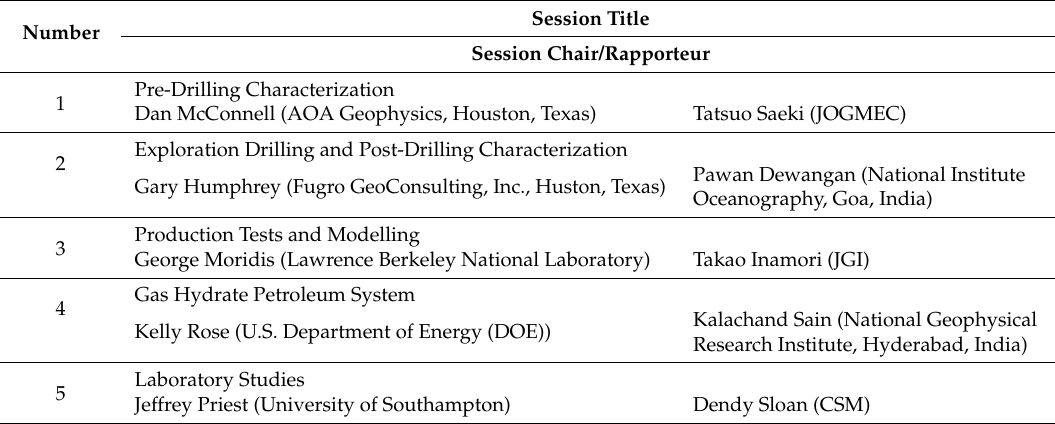
Table 8. Breakout sessions (title and